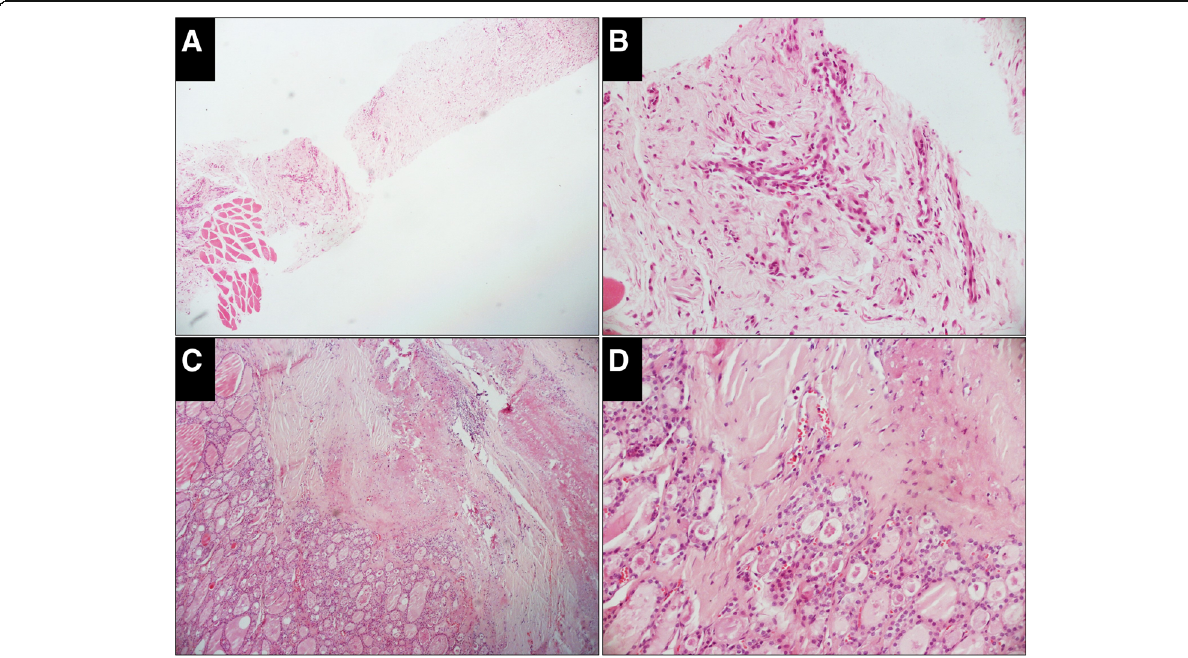
Fig. 1 Case classified as unsatisfactory in the CNB specimen while benign in the resected specimen (H&E). a, The CNB specimen consists of an acellular fibrotic lesion with a few striated muscles at one end (× 50). b, High-power view of the fibrotic lesion shows no thyroid follicles (× 200).